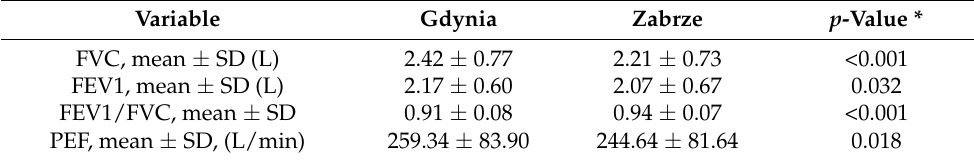
Table 3. Spirometry variables among schoolchildren in Gdynia and